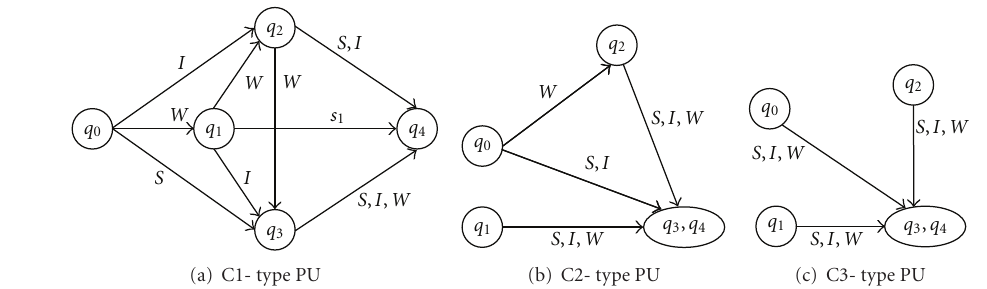
Figure 5: Transition rules of a PU. S, I, and W indicate a signal from a highly activated C1-, C2-, and C3-type PU, respectively. For example, if C1-type PU in the state q 0 receives an I signal it will enter the moderately activated state q 2 . If it receives a W signal it will enter the more activated state q 3 . For example, a C1-type PU in the state q 0 will enter the less active state q 1 when it receives a signal from a neighboring C3-type PU (i.e., signal W). We note that if a PU does not receive a stimulus before its next update time, it will go into state q 1 if it was in state q 2 , or enter state q 0 if it was in q 1